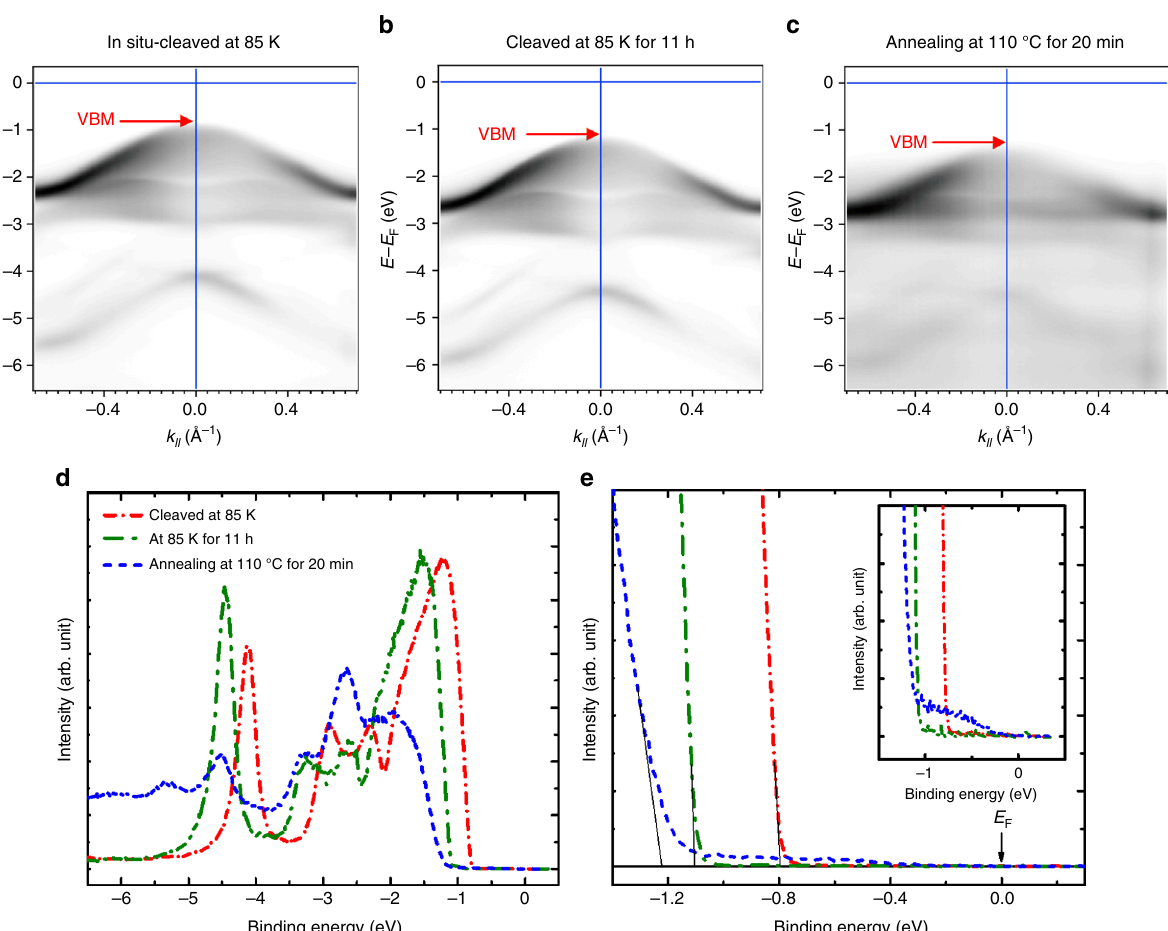
Fig. 8 Aging effect at low temperature and annealing effect of the in situ-cleaved fresh surfaces of a MoS 2 single crystal. The E versus k ‖ valance band measurements for the a in situ-cleaved surface at 85 K, b the in situ-cleaved surface at 85 K for 11 h, and c the in situ-cleaved surface annealed at 110 °C for 20 min of an MoS 2 crystal recorded with a 42-eV photon energy at 85 K. d , e The normal emission spectra at the Γ point with different binding energy scales for the in situ-cleaved surface at 85 K, the in situ-cleaved surface at 85 K for 11 h, and the in situ-cleaved surface annealed at 110 ºC for 20